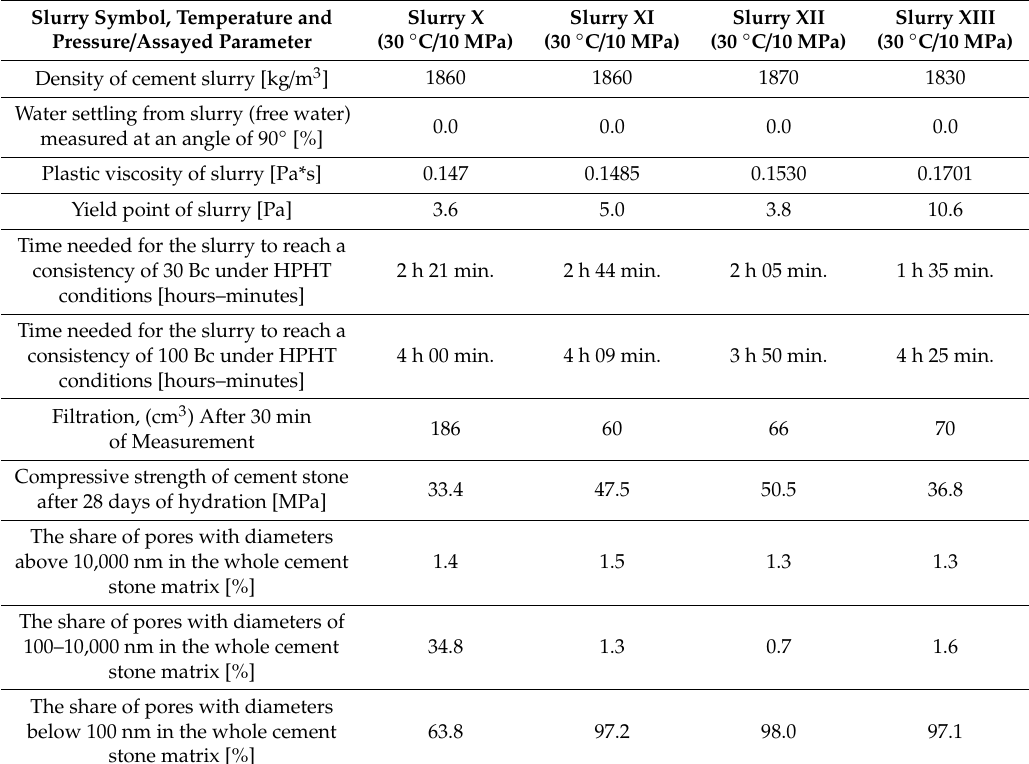
Parameters of slurries and cement stones with an addition of n-SiO 2 tested under HPHT